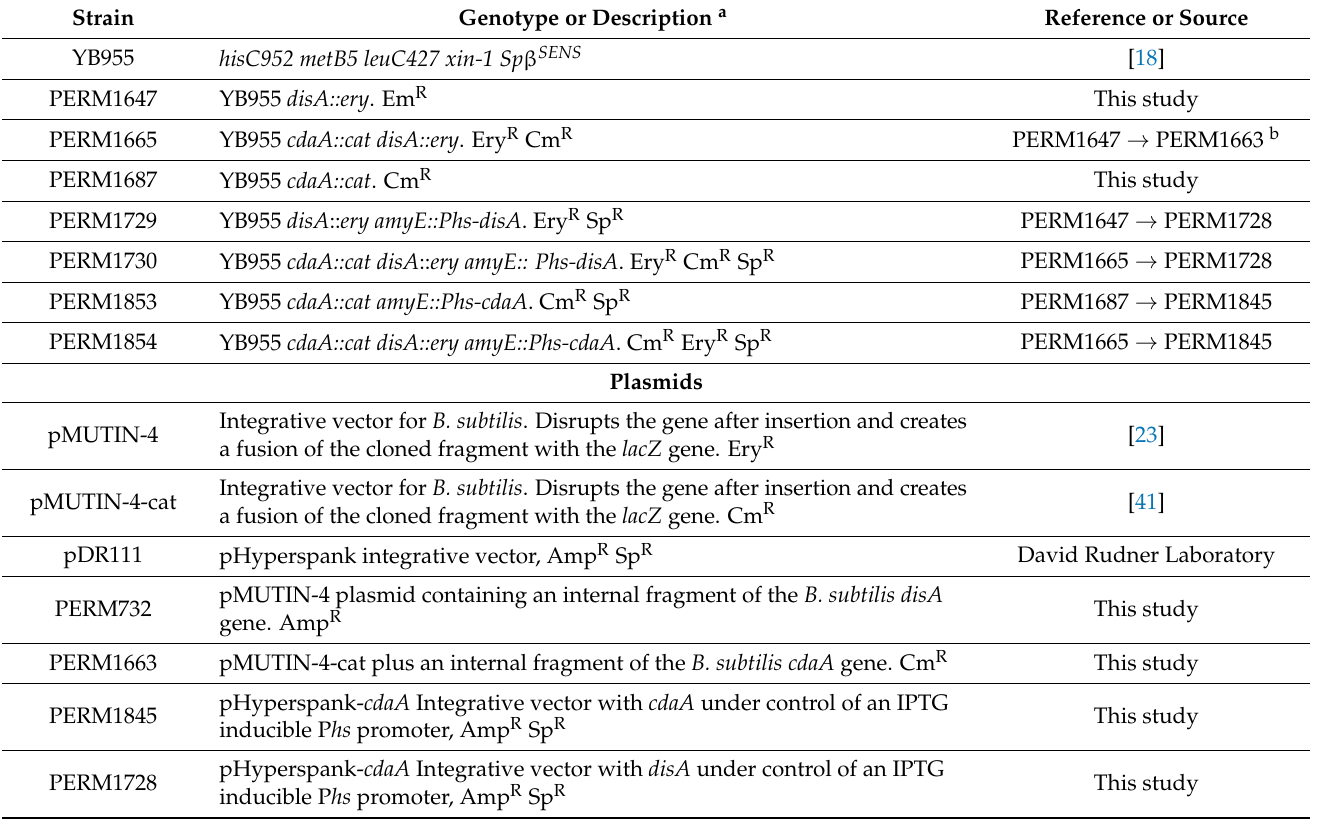
Table 2. Bacillus subtilis strains and plasmids used in this